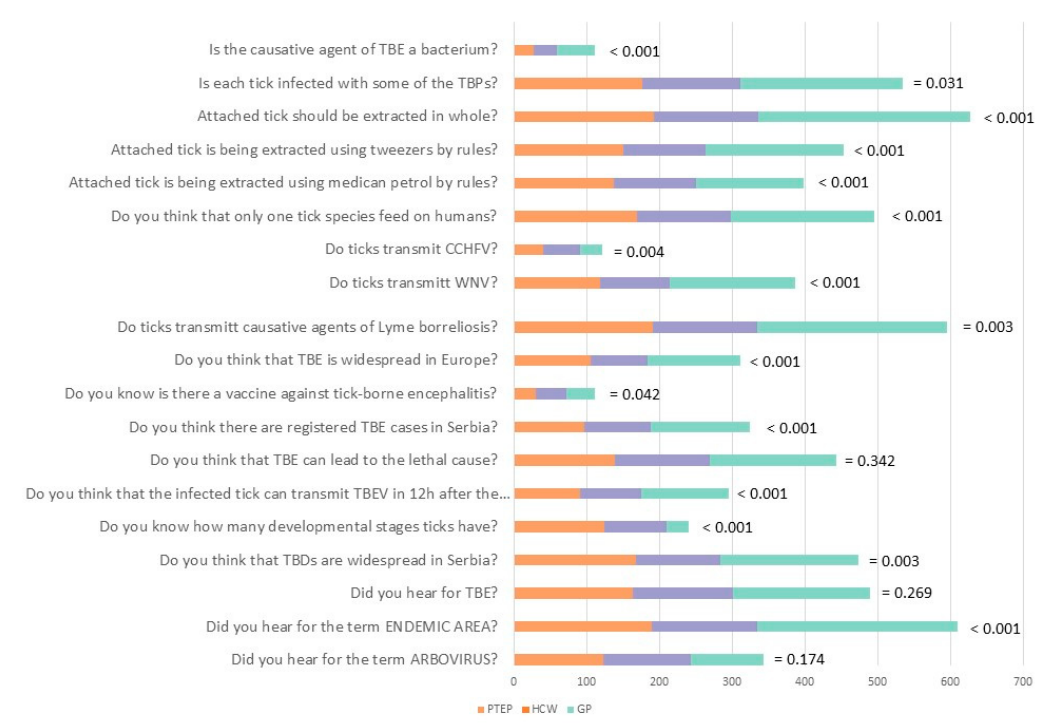
Figure 1. Questions on the knowledge and opinion towards ticks and tick-borne diseases and the answers of the participants from the three different groups.